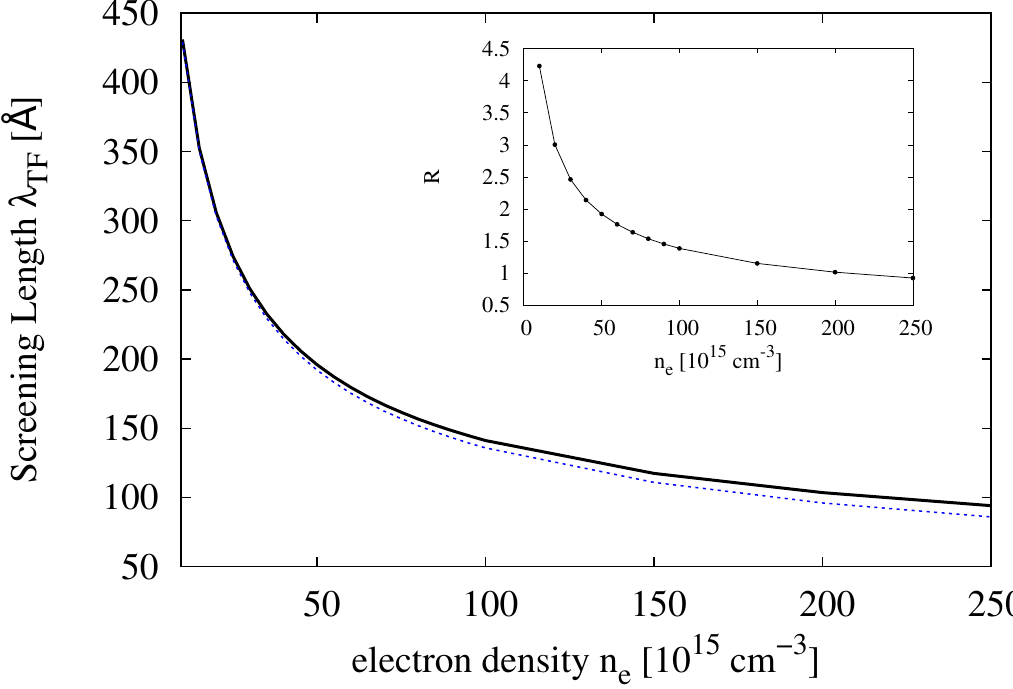
Figure 1. ( Main panel ) Screening length (solid line) and Debye–H¨uckel screening length (dashed line) versus electron density for an n-type GaAs at T = 300 K. Here, n the latter being the impurity concentration. ( Inset ) R from Equation (13) versus electron density. The parameters are as in the main